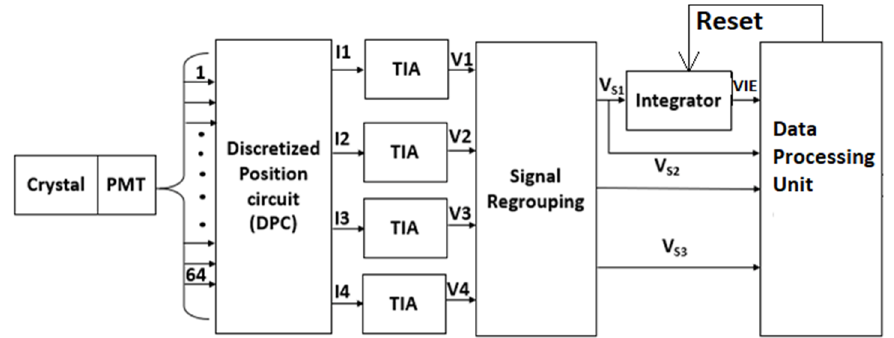
Figure 1. Signal readout block diagram.